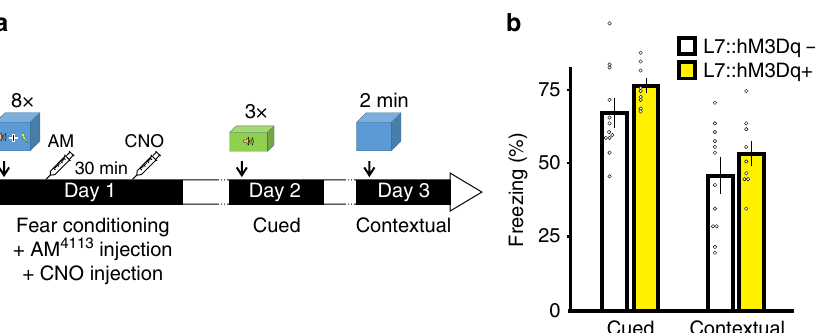
Fig. 9 Endocannabinoid receptor antagonist prevents the disruption of memory consolidation by activation of Gq pathways in Purkinje cells. a The protocol used for fear conditioning and memory retention testing was identical to the one described in Fig. 8, except that both L7::hM3Dq + ( n = 9 animals) and L7::hM3Dq − ( n = 12 animals) mice received an additional i.p. injection of AM 4113 (3 mg/kg), a CB1 receptor neutral antagonist immediately after acquisition, 30 min before the CNO injection. b Group data showing that activation of Gq DREADD in Purkinje cells no longer impaired cued memory retention following injection of AM 4113 . Group comparisons by two-sided paired t -test (L7::hM3Dq + (cued) CNO vs CNO + AM, P < 0.001). Data in b are presented as mean values ± SEM. Statistical analysis and P values can be found in Supplementary Table 4 and original data in the Source Data